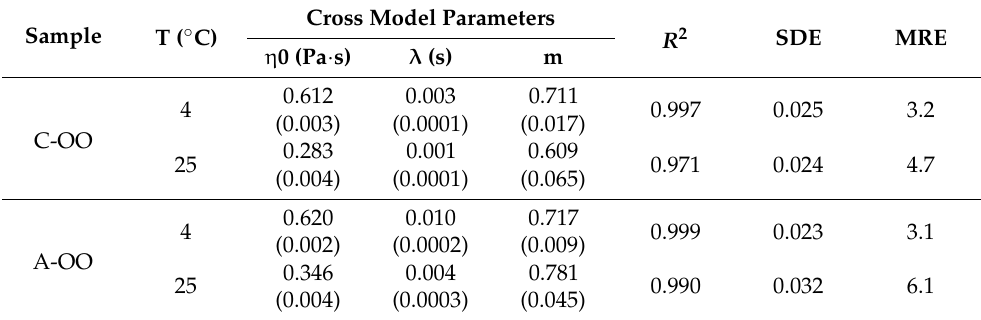
Table 1. Parameters of modified Cross model (Equation (1)) for the studied emulsions at 4 ◦ and 25 ◦ C temperatures. Values are expressed as mean ( ± standard deviation). C-OO = water-in-oil emulsion (chitosan and olive oil), A-OO = water-in-oil emulsion (chitosan and olive oil). η 0 = zero-shear of viscosity, λ = relaxation time, m = 1 − n (n is the flow index), R 2 : Coefficient of determination, SDE: Standard deviation of the estimate, MRE: Mean relative